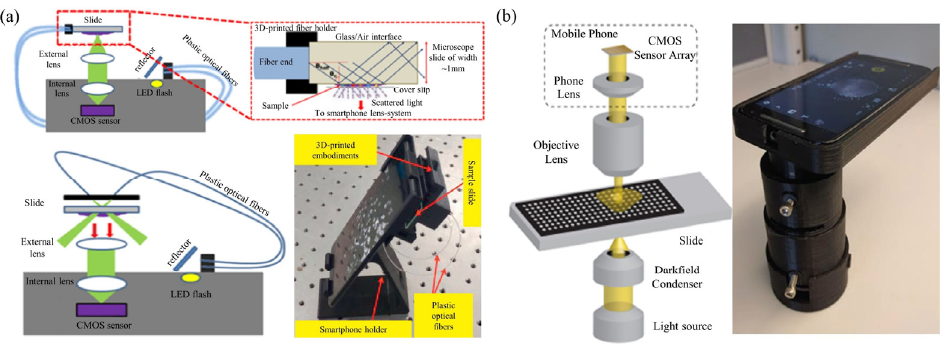
Figure 10. Smartphone-based dark-field microscopy based on ( a ) external angular illumination [84], and ( b ) a dark-field condenser [83].